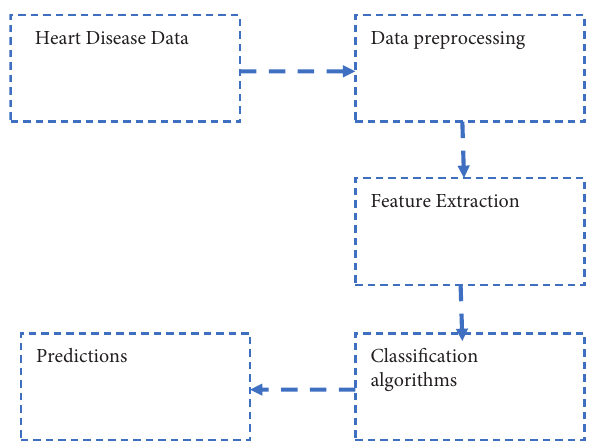
Figure 1: A framework for heart disease